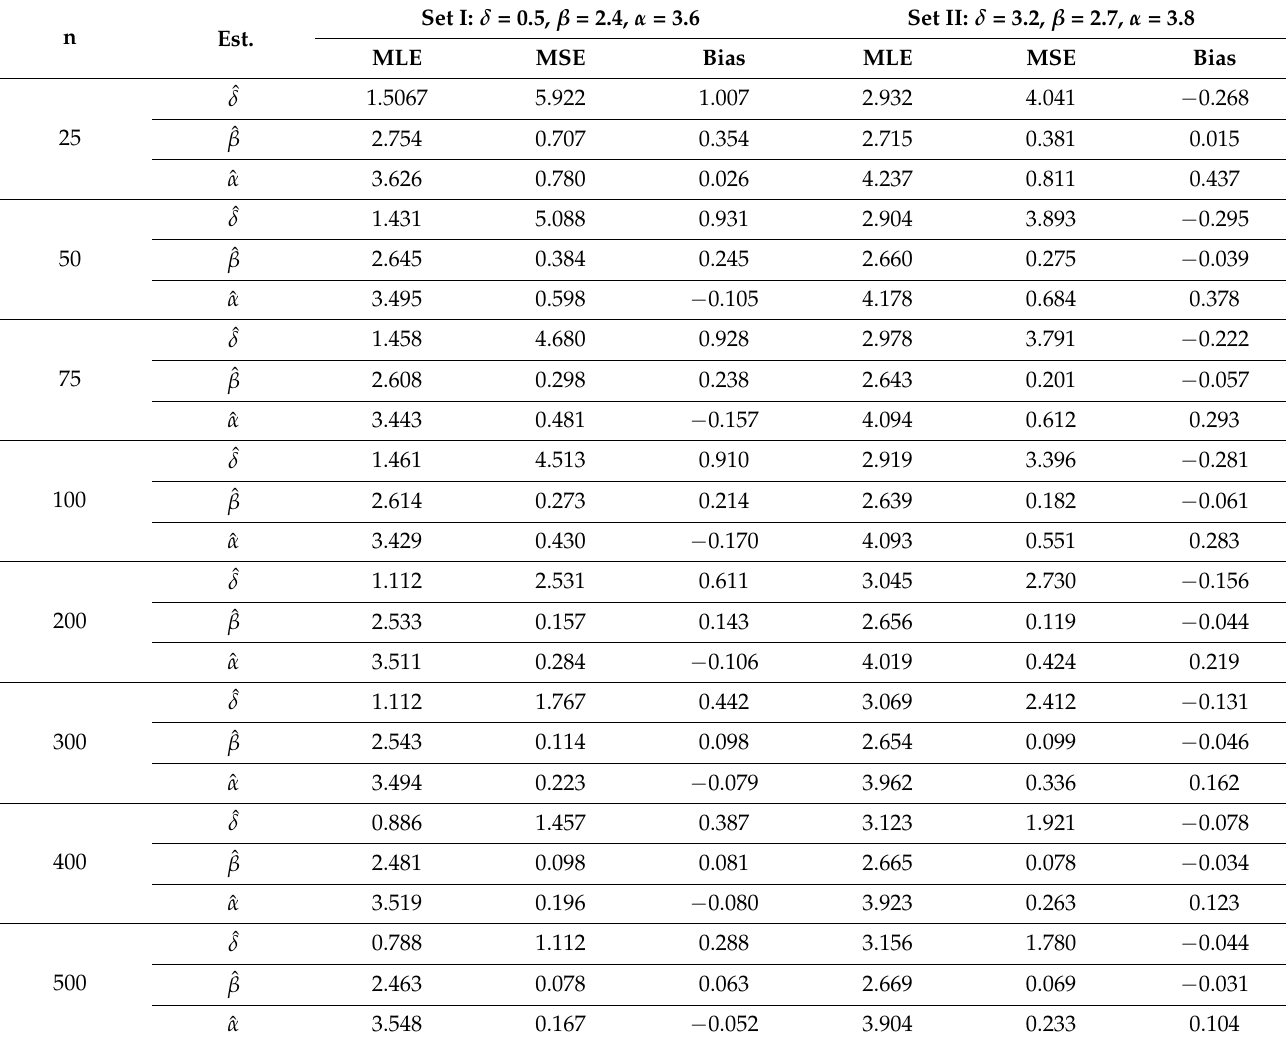
Table 2. SRs of the NGLog–Weib distribution for Set I and Set